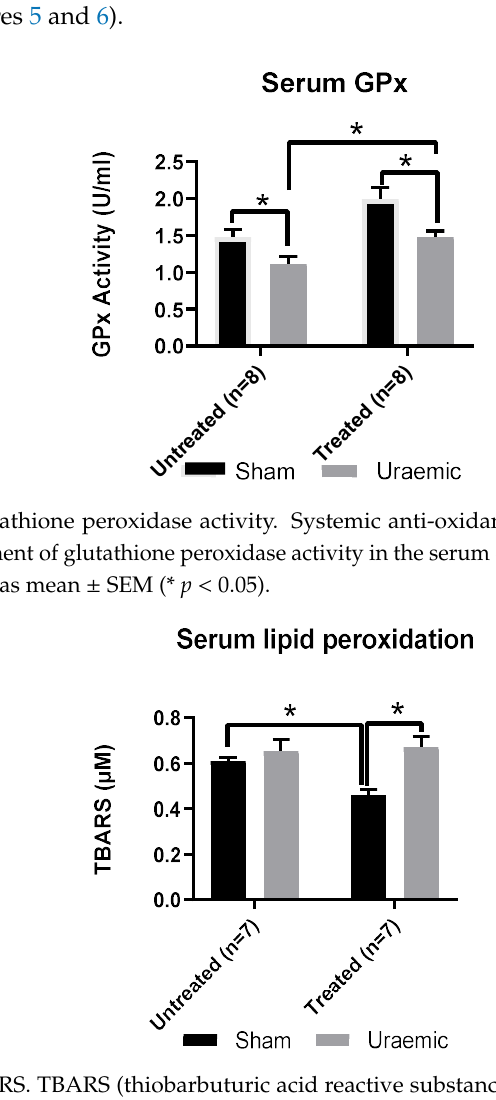
Figure 4. Transferrin analysis ( A ): Serum transferrin level and ( B ): Urinary transferrin loss at various stages of uraemia. Data are presented as mean ± SEM (* p < 0.05, ** p < 0.01).